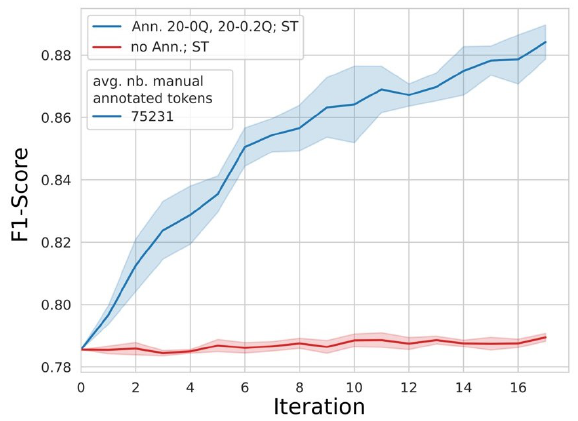
Figure 5. Evolution of model performance (F1-score) with training when (1) only self-learning and no manual annotation was performed (red line) and (2) both self-learning and manual anno- tation were performed (blue line). The shadowed areas illustrate in each case the associated 95% confidence interval.